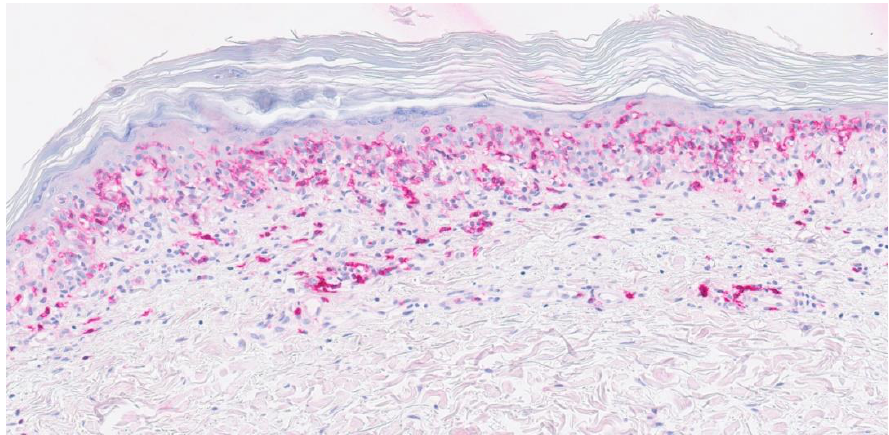
Figure 3. The infiltrating lymphocytes of the epidermis were mainly positive for CD8 on immuno- histochemistry (×200).